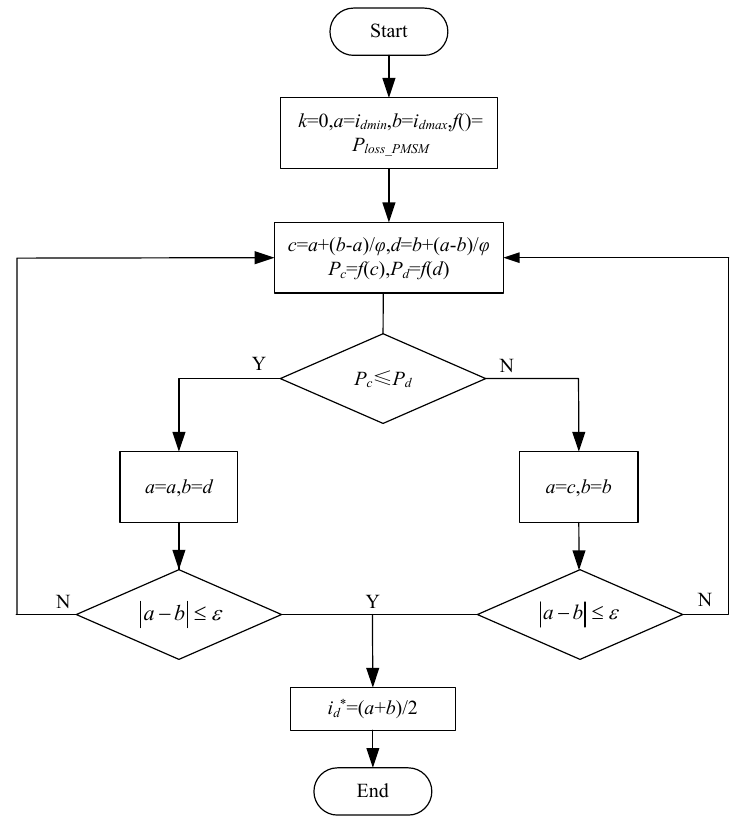
Figure 9. Flowchart of the golden section search procedure.